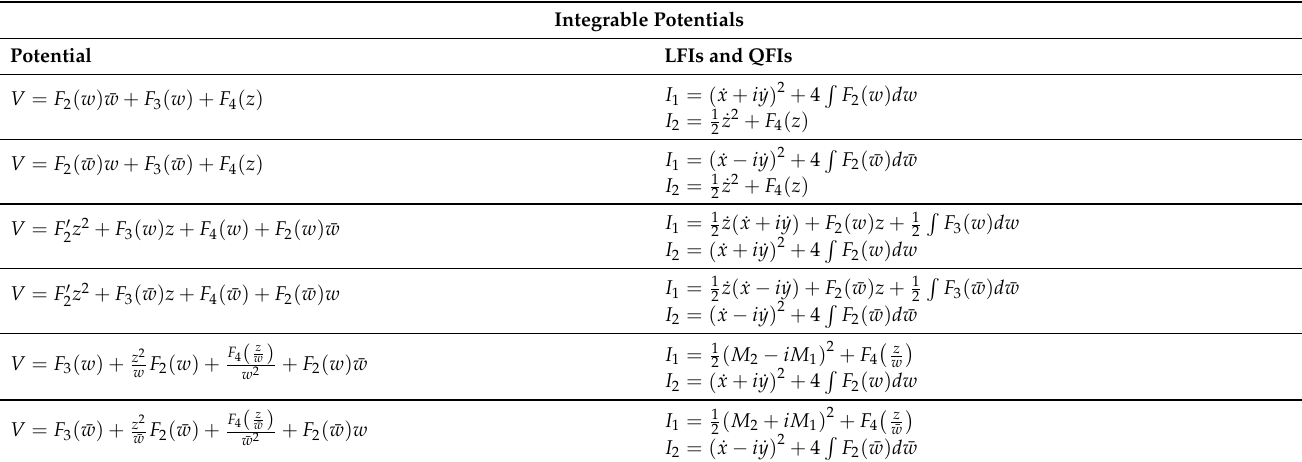
Table 5. Integrable potentials V ( x , y , z ) in E 3 that admit QFIs of the type I ( 1,1 ) .